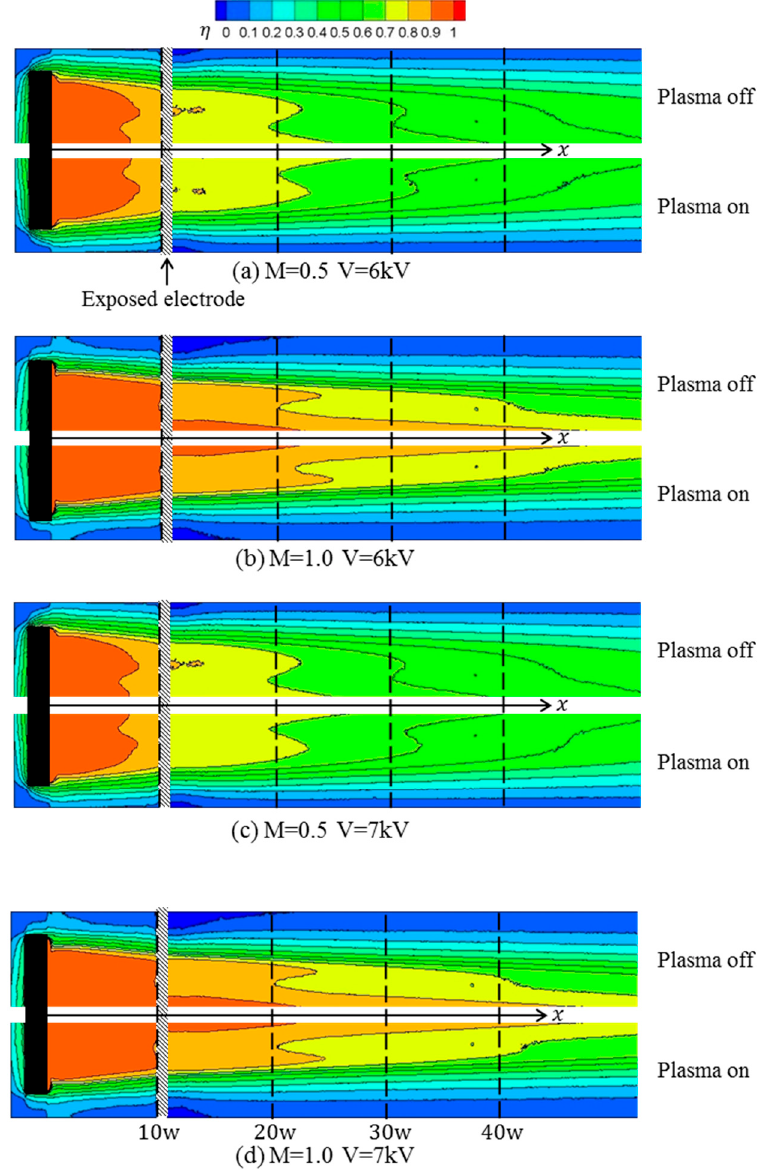
Figure 8. Distributions of film cooling effectiveness ( (cid:1838) (cid:2915) = 10 w).